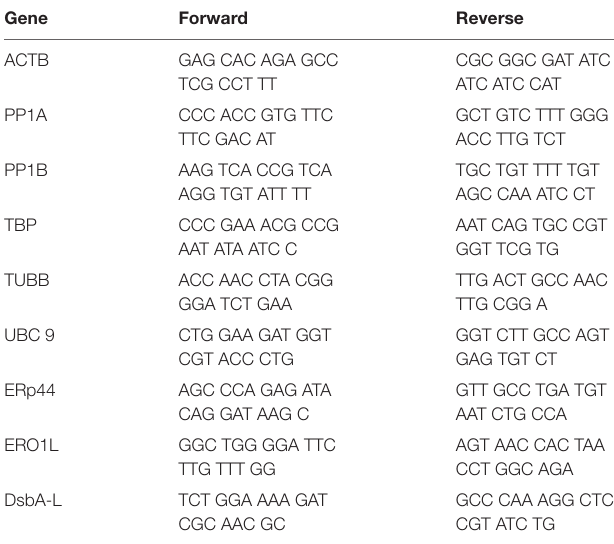
TaBlE 4 | Real-time reverse transcriptase polymerase chain reaction